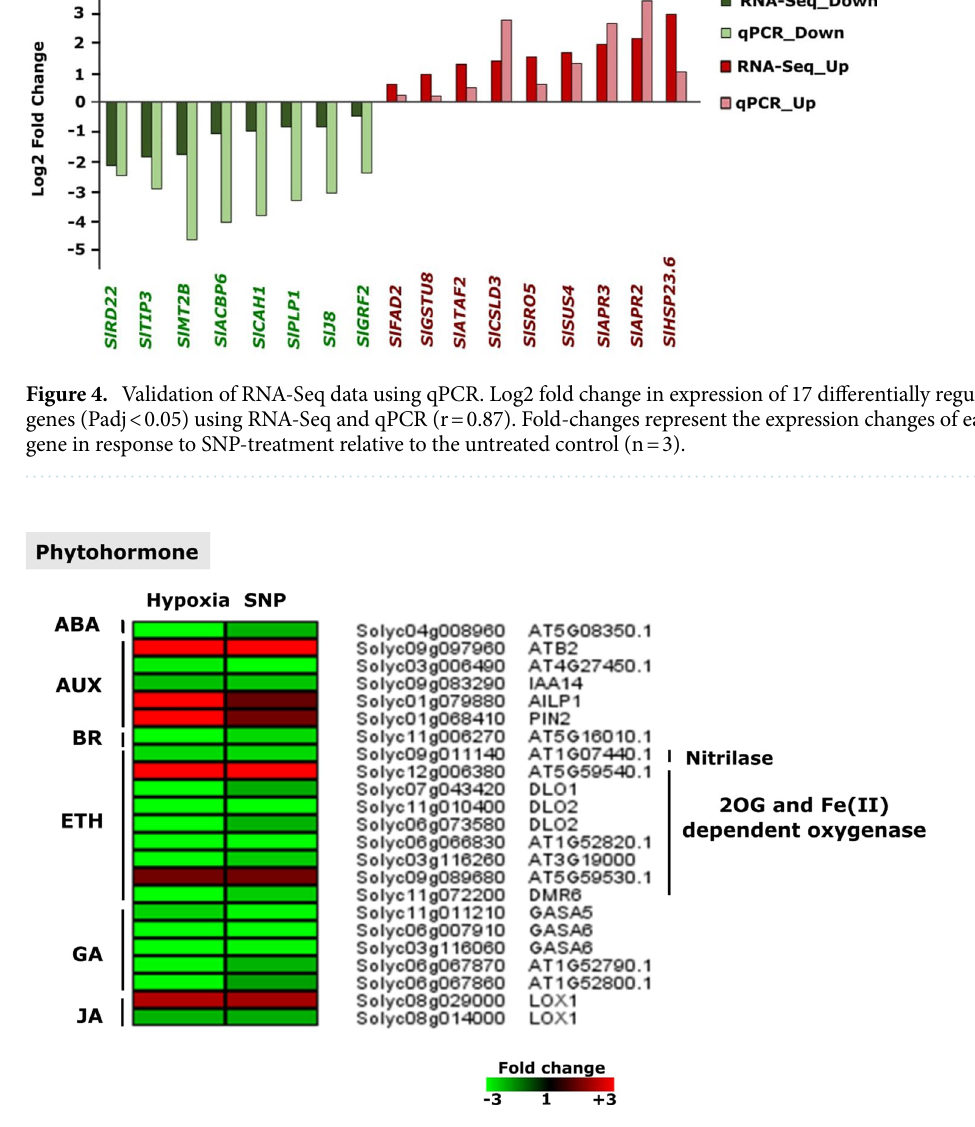
Figure 5. Transcriptional changes of genes related to different phytohormone categories. The heat map displays the up-regulated (red bars) or down-regulated (green bars) tomato genes and their Arabidopsis thaliana homologs in response to hypoxia and SNP-treatment. Depicted are differentially expressed genes ( Padj < 0.05) ( n = 3). ABA, abscisic acid; AUX, Auxin; BR, brassinosteroid; ETH, ethylene; GA: gibberellin; JA, jasmonate; 2OG, 2-oxoglutarate; ATB2, NAD(P)-LINKED OXIDUREDUCTASE-LIKE PROTEIN; IAA14 , INDOLE-3- ACETIC ACID INDUCIBLE 14 ; AILP1 , ALUMINIUM INDUCED PROTEIN WITH YGL AND LRDR MOTIFS ; PIN2 , PIN-FORMED 2 ; DLO1 , DMR6-LIKE OXYGENASE 1 ; DLO2 , DMR6-LIKE OXYGENASE 2 ; DMR6 , DOWNY MILDEW RESISTANT 6 ; GASA5 , GAST1 PROTEIN HOMOLOG 5 ; GASA6 , GAST1 PROTEIN HOMOLOG 5 ; LOX1 , LIPOXYGENASE 1